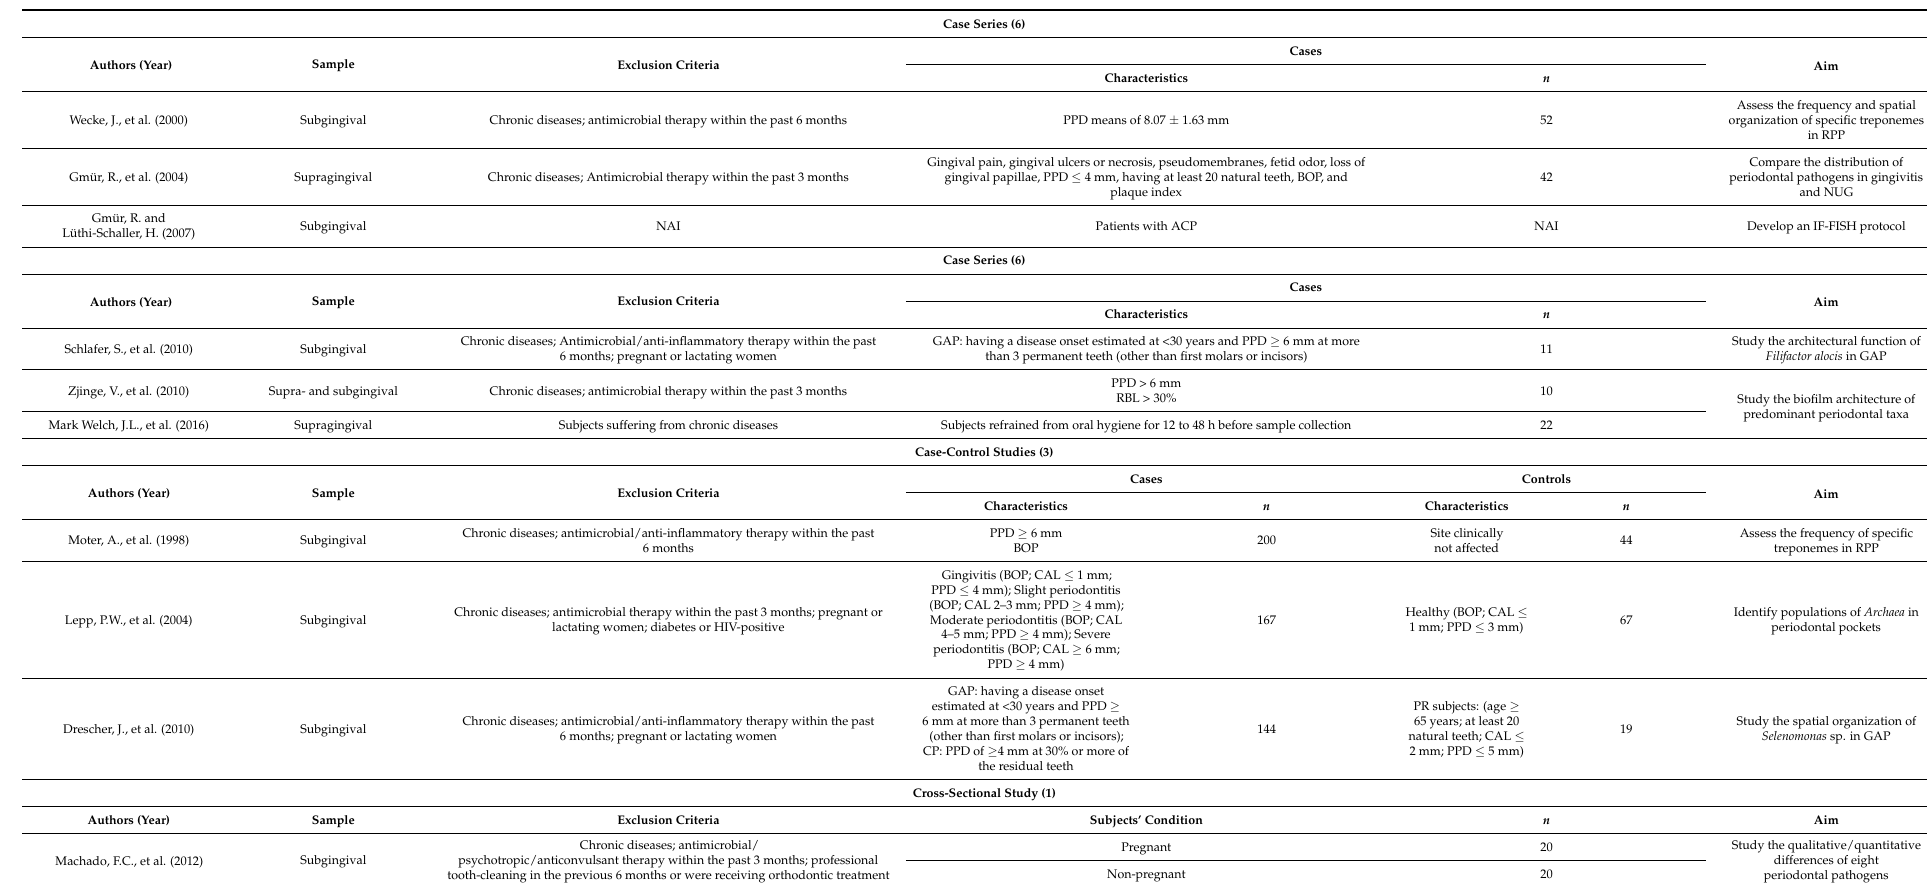
Table 1. Characteristics of the included studies, such as location of the sampled dental biofilm, exclusion criteria, characteristics of the controls and/or cases, and the purpose of each study. The abbreviations can be found at the bottom of the